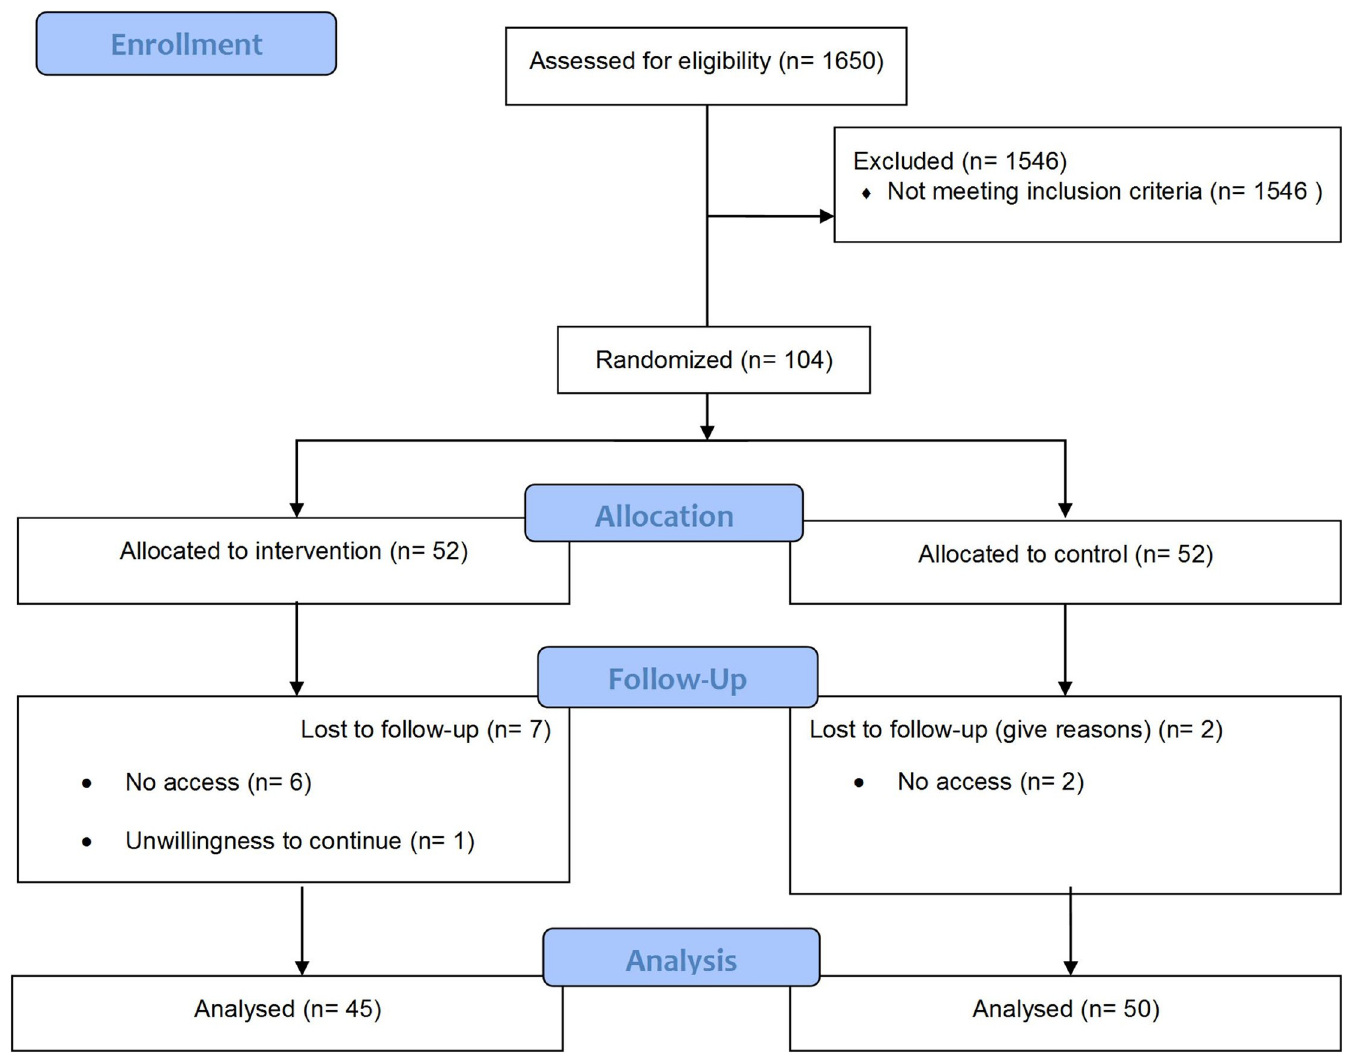
Fig 3. Consort flow